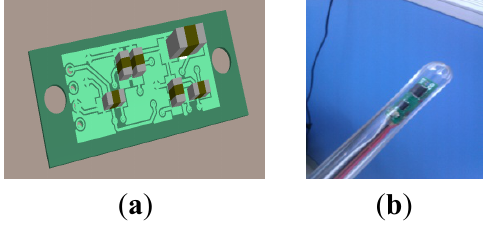
Figure 2. The minimized MARG sensor array. ( a ) The 3D model of the senor array’s PCB; ( b ) The photo of the senor array which is sealed in a glass tube.